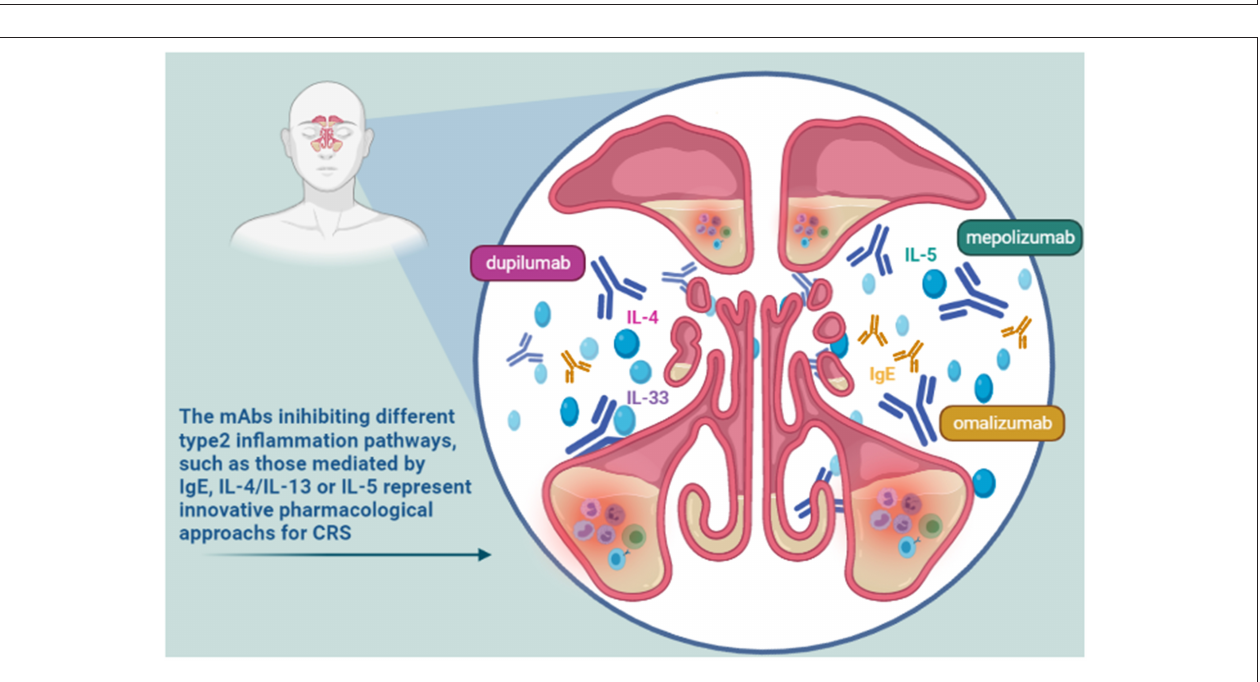
FIGURE 2 | Some target pathways target of mAbs effective in chronic rhinosinusitis (CRS). as chronic rhinosinusitis (CRS) (11, 12). CRS is characterized by local inflammation of the upper airways and sinuses which persists for at least 12 weeks (13). It affects ∼ 3% of the